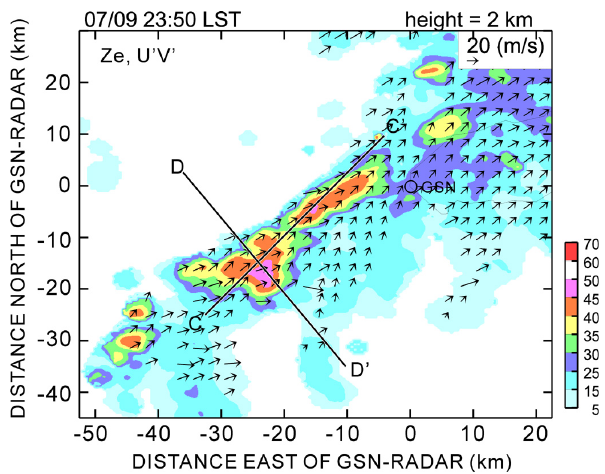
Fig. 14. Same as Fig. 12, but for 23:50LST, 9 July 2007. The bold lines indicate the vertical cross-sections in Fig. 15.